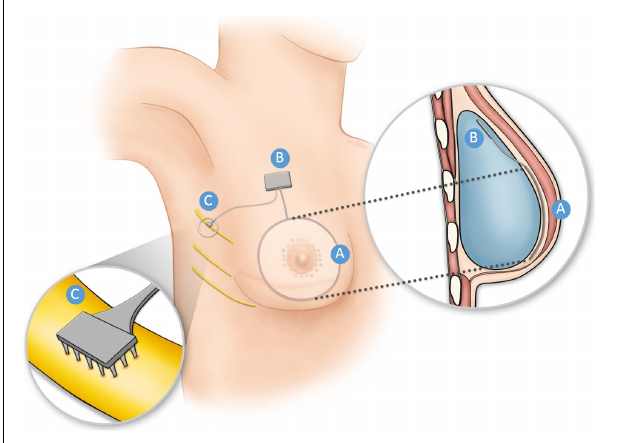
FIGURE 1 | Schematic illustration of the Bionic Breast concept for a breast reconstructed using an implant. An array of pressure sensors (A) is placed under the reconstructed or tattooed nipple and the surrounding region. The output of the sensors triggered by pressure applied to the skin is converted into electrical stimulation pulse trains via a hermetically sealed electronic circuit (B) , shown here to be encased in the breast implant. The electrical stimulation pulse trains are delivered through one or more electrode arrays (C) implanted around or in the residual intercostal nerve(s) that innervated the nipple areolar complex before mastectomy. Nerve stimulation results in a sensation projected to the nipple areolar region. Much of this technology has already been developed to restore sensation to bionic